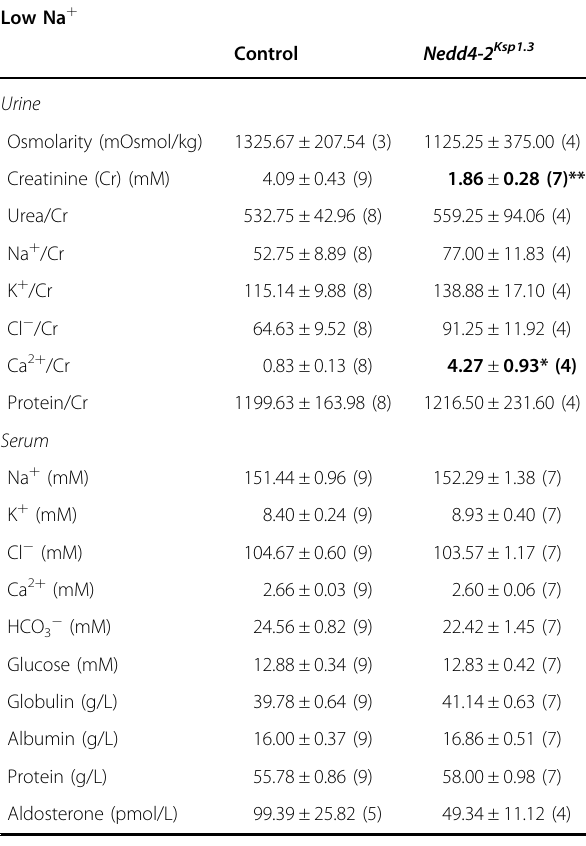
Table 2 Urine and serum analysis of control and Nedd4- 2 Ksp1.3 mice on low Na + diet. Low Na + Control Nedd4-2